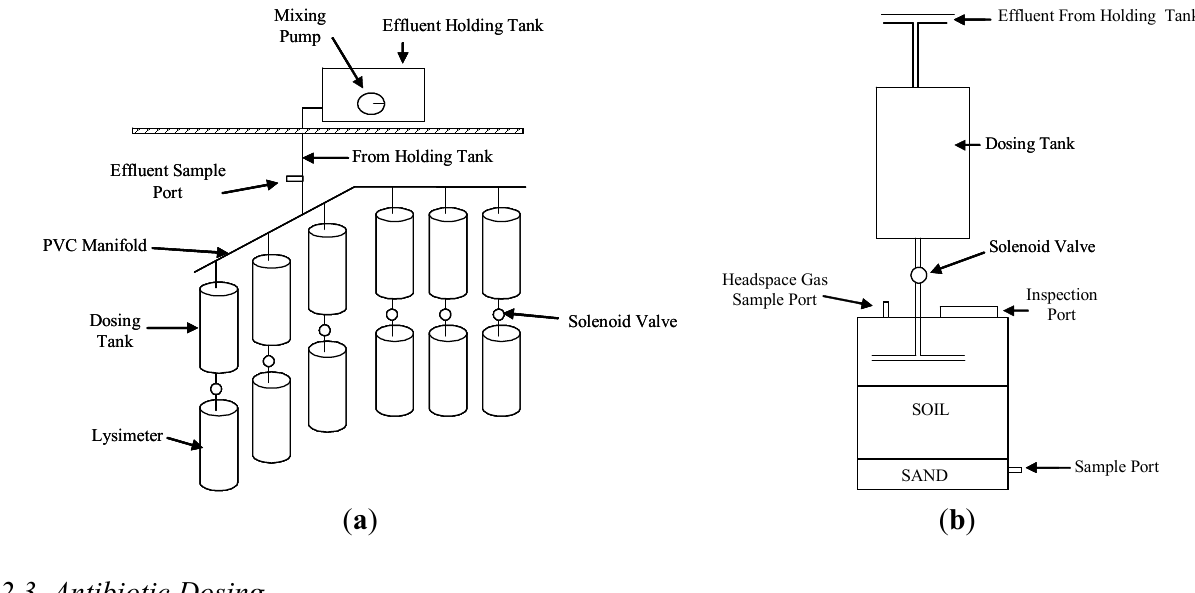
Figure 1. ( a ) Schematic diagram of laboratory facility and ( b ) leachfield mesocosms employed in this study. Drawings are not to scale (after Patenaude et al.